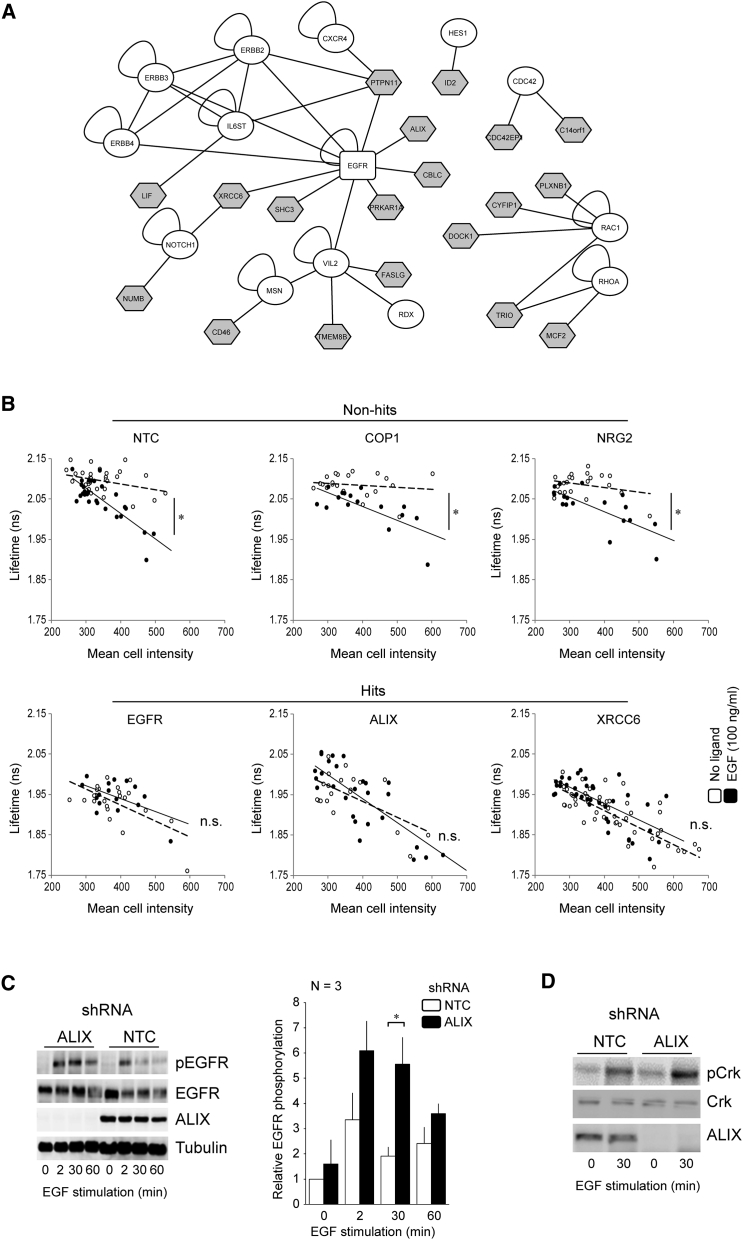
Picchu-X Screen to Identify Hits Affecting EGFR Activity(A) The protein interaction sub-network of the 20 hits identified in a high-content siRNA screen and their connection to seed set proteins. The sub-network was extracted from a larger network of 533 proteins obtained from the Human Protein Reference Database (HPRD) based on their direct associations with seed-set proteins and 1 (or more) other network member (central rectangle indicates primary seed or EGFR; white ellipses indicate additional seeds; shaded polygons indicate screen hits).(B) FLIM-intensity scatterplots and associated regression analysis of six example experimental groups (three non-hits and three hits). Each data point shows mean fluorescence lifetime plotted against mean fluorescence intensity for a single cell. Pearson correlation coefficients describe the association between lifetime and intensity for the EGF-treated (solid circles) and non-treated (empty circles) subgroups, and the difference in r values was used to evaluate the effects of target protein KD on EGFR activity (∗p < 0.05).(C and D) Lysates of the indicated EGF-stimulated HCC1954 cell lines were examined by western blotting. Bar chart in (C) summarizes densitometry analysis of phospho-EGFR levels normalized to tubulin (n = 3 independent experiments ± SEM (∗p < 0.05, two-tailed Student’s t test). Similarly, immunoblots for phospho-CrkII are shown in (D).See also Figures S1 and S2.